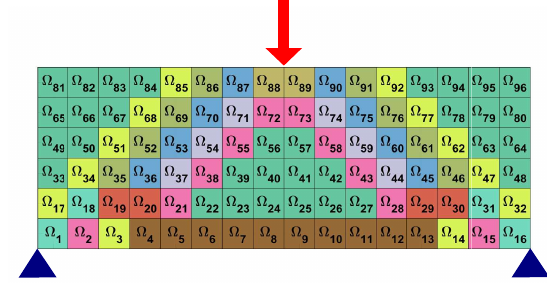
Figure 3. An illustration of the beam problem aris- ing in modular topology optimization. The distinct colours represent 16 different types of 96 modules, which constitute the beam’s subdomains Ω s .